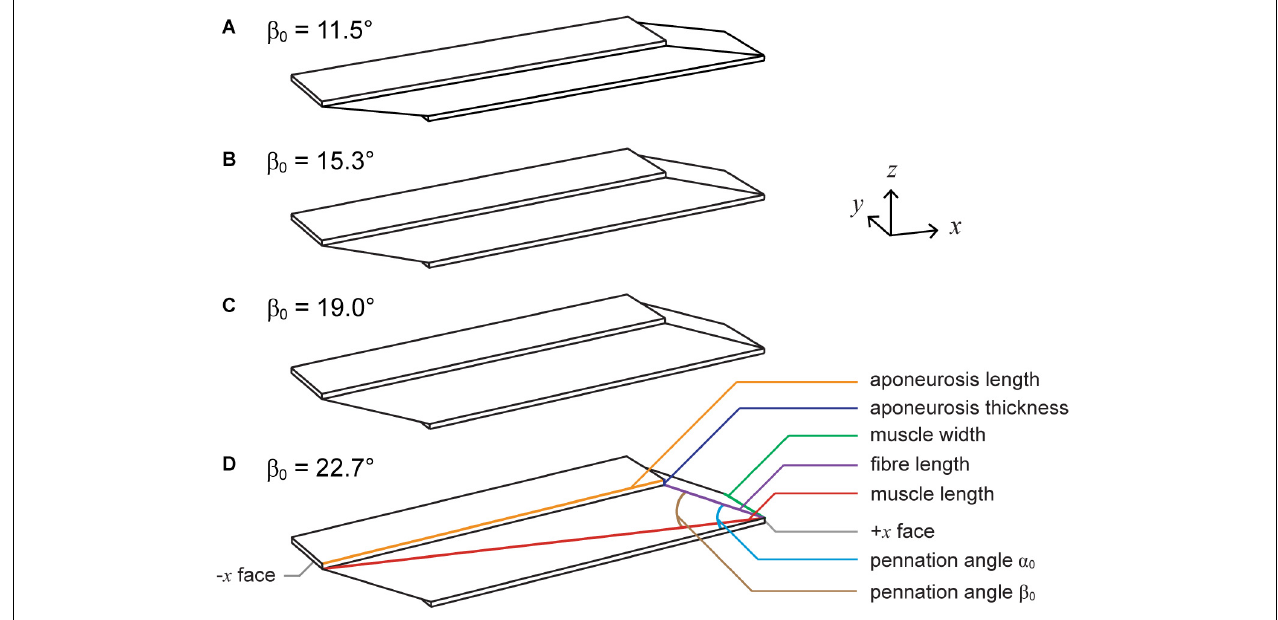
FIGURE 1 | Muscle geometries. We simulated muscle with initial pennation angles relative to the bottom aponeurosis α 0 of 15 ◦ (A) , 20 ◦ (B) , 25 ◦ (C) , and 30 ◦ (D) , which resulted in initial pennation angles relative to the – x axis β 0 of 11.5 ◦ , 15.3 ◦ , 19.0 ◦ , and 22.7 ◦ . To vary α 0 , we altered the initial fibre length and kept the aponeurosis length, aponeurosis thickness, muscle width, and muscle length